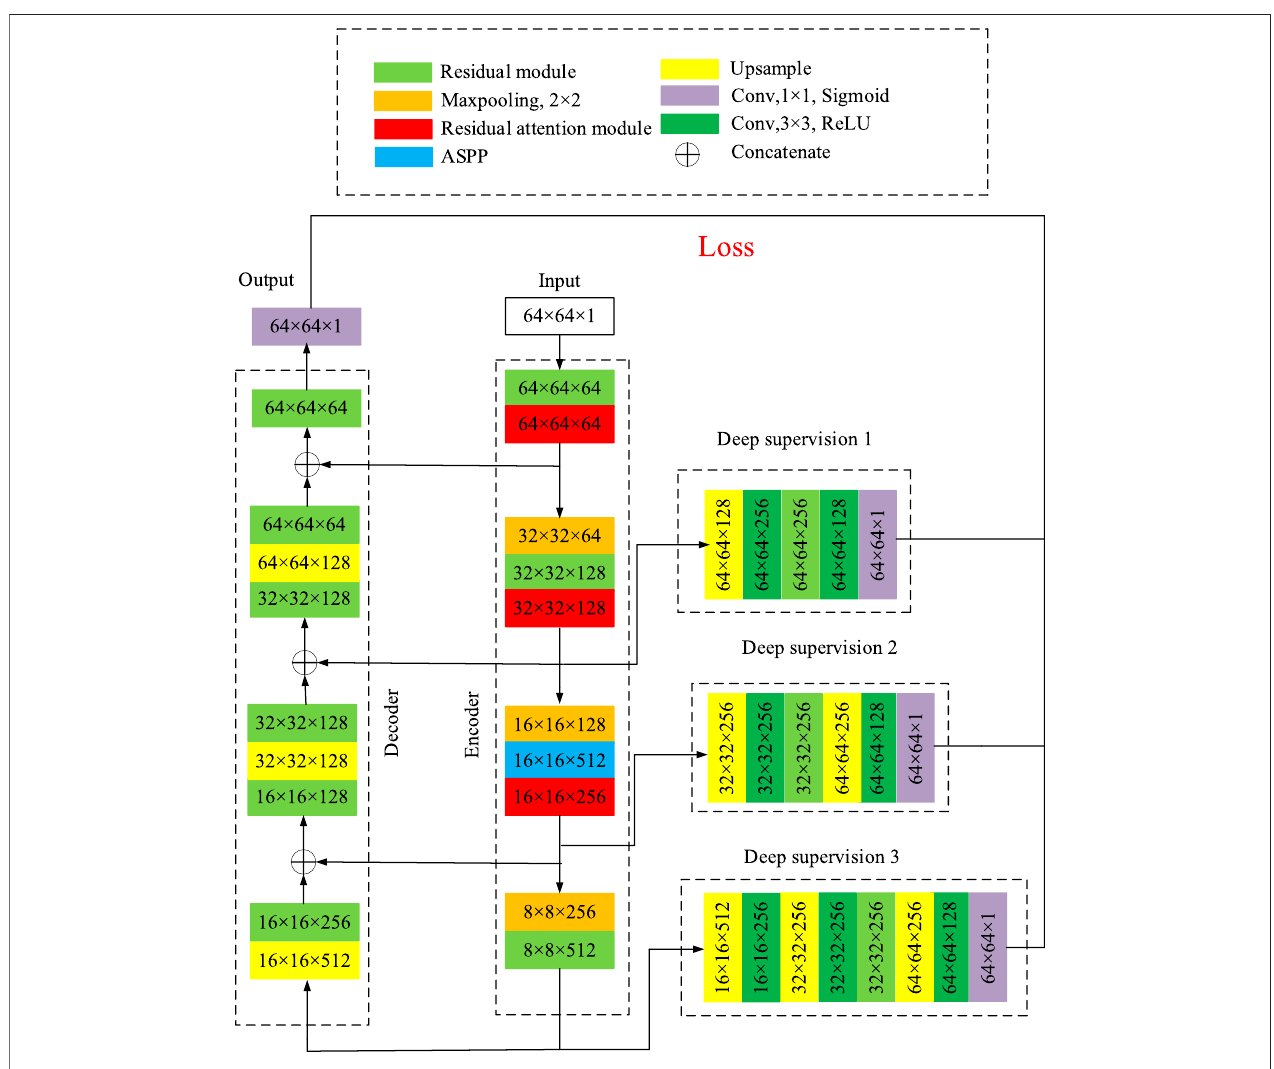
FIGURE 5 | Structure diagram of the retinal vessel segmentation